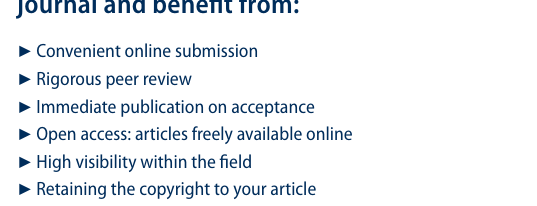
gate dielectric: a study on the formation of germanate. IEEE Trans Electron Devices 63(12):4888 – 92 34. Li XF, Cao YQ, Li AD, Li H, Wu D (2012) HfO 2 /Al 2 O 3 /Ge gate stacks with small capacitance equivalent thickness and low interface state density. ECS Solid State Lett 1(2):N10 – N2 35. Mi Y, Wang S, Chai J, Pan J, Huan A, Ning M et al (2006) Energy-band alignments at LaAlO 3 and Ge interfaces. Appl Phys Lett 89(20):2107 36. Dalapati GK, Oh HJ, Lee SJ, Sridhara A, Wong ASW, Chi D (2008)